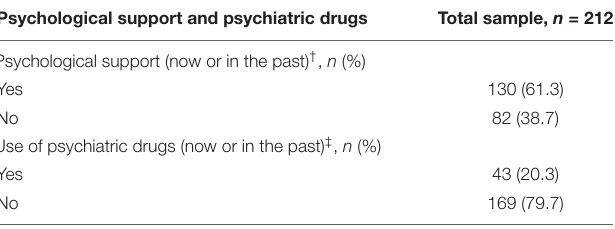
TABLE 4 | Psychological support and psychiatric